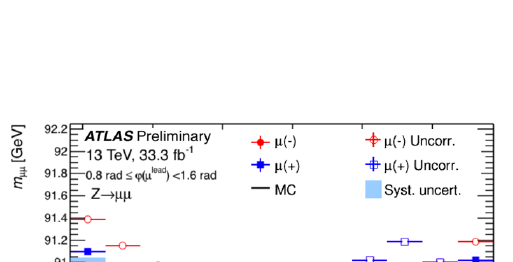
Figure 1. Muon reconstruction e ffi ciencies for the Loose / Medium / Tight identification algorithms µµ events as a function of the muon measured in Z → pseudorapidity for muons with p T > 10 GeV. The prediction by the detector simulation is depicted as open circles, while filled dots indicate the observation in collision data with statistical errors. The bottom panel shows the ratio between expected and observed e ffi ciencies, the e ffi ciency scale factor. The errors in the bottom panel show the quadratic sum of statistical and systematic uncertainty. Figure from [5]. Figure 2. Muon reconstruction e ffi ciencies for the Medium identification algorithm measured in µµ and Z µµ events as a function of the J /ψ → → muon momentum. The prediction by the detector simulation is depicted as empty circles (squares), while the full circles (squares) indicate the observation in collision data. Only statistical errors are shown in the top panel. The bottom panel reports the e ffi ciency scale factors. The darker error bands indicate the statistical uncertainty, while the lighter bands indicate the sum of the statistical and systematic uncertainties in quadrature. Figure from [5].